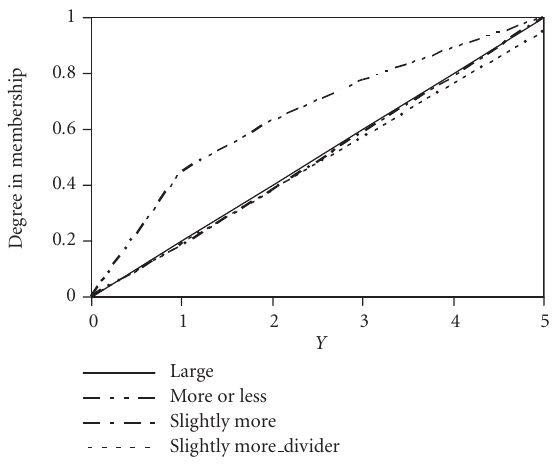
Figure 3.8. Schematic illustration of linguistic hedge “slightly